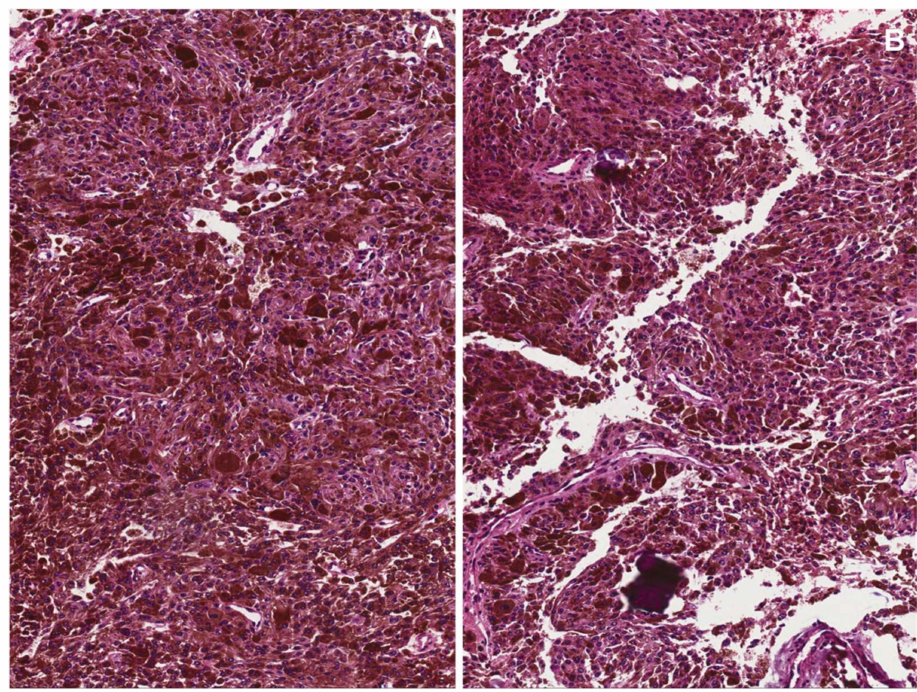
Figure 25. Malignant melanotic nerve sheath tumor. ( A ) Tumor is composed of heavily pigmented plump spindled to polygonal cells arranged in interlacing fascicles or nests. ( B ) The presence of psammoma bodies (arrows) is a characteristic feature of this